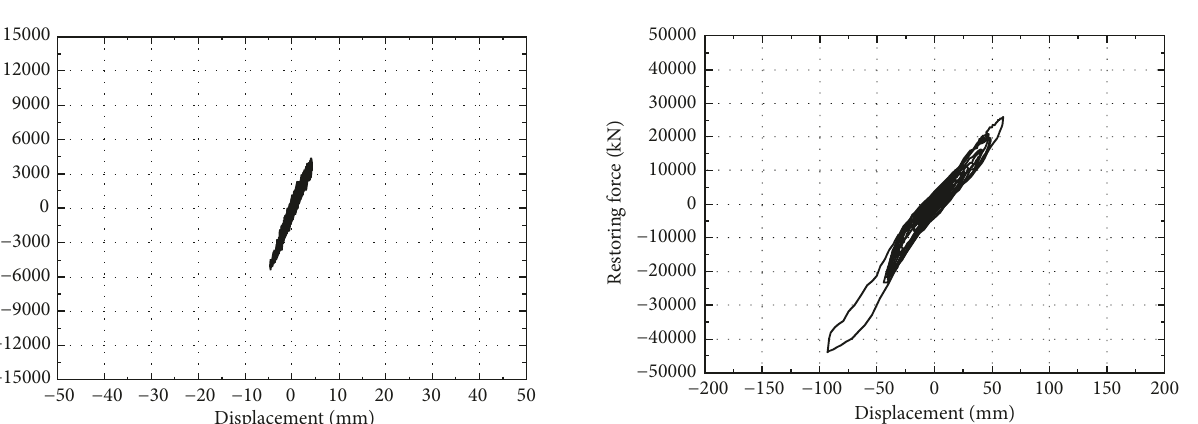
Figure 26: Hysteresis curve of intensity 7 frequently of Alaska (longitudinal input).